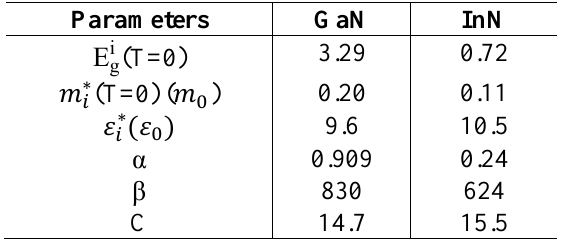
Table 1: The physical characteristics of GaN and